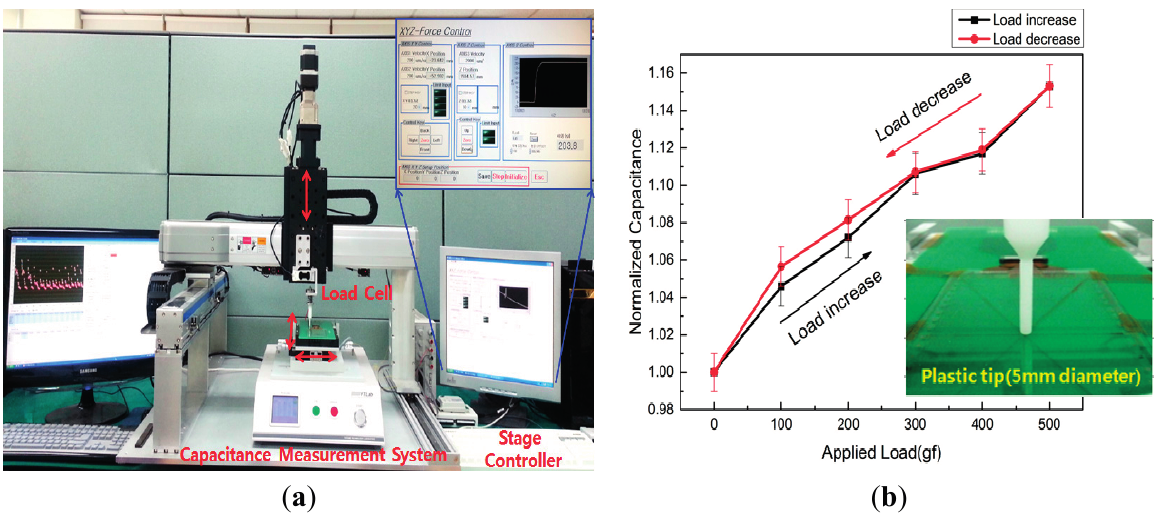
Figure 5. The system used to evaluate the force sensing touch screen and a graph of mutual capacitance variation against the force applied; ( a ) The evaluation system is composed of capacitance measurement equipment, a load cell for detecting the applied force and a stage controller for setting the location of the applied force on the sensing touchscreen; ( b ) A graph of mutual capacitance variation against applied